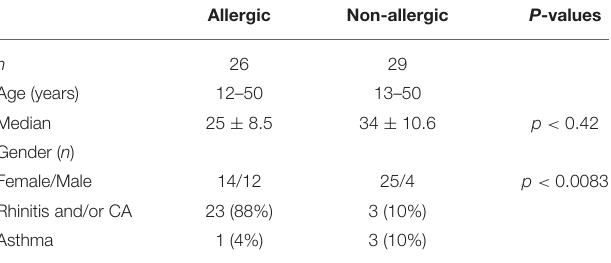
TABLE 1 | Demographic and clinical characteristics of the study population.